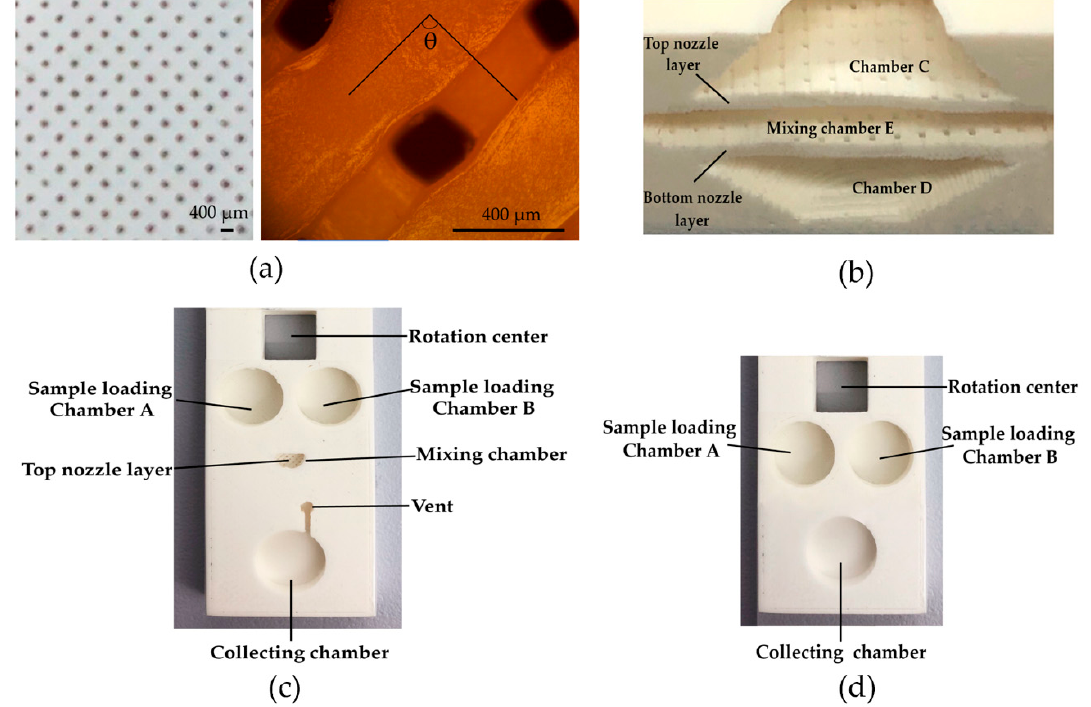
Figure 4. ( a ) A photo image of the 3D printed micronozzles; ( b ) a microscope image of the 3D printed micronozzles, θ = 90 ◦ ; ( c ) a photo image of the 3D printed jet mixer; ( d ) a photo image of the 3D printed Y-shaped